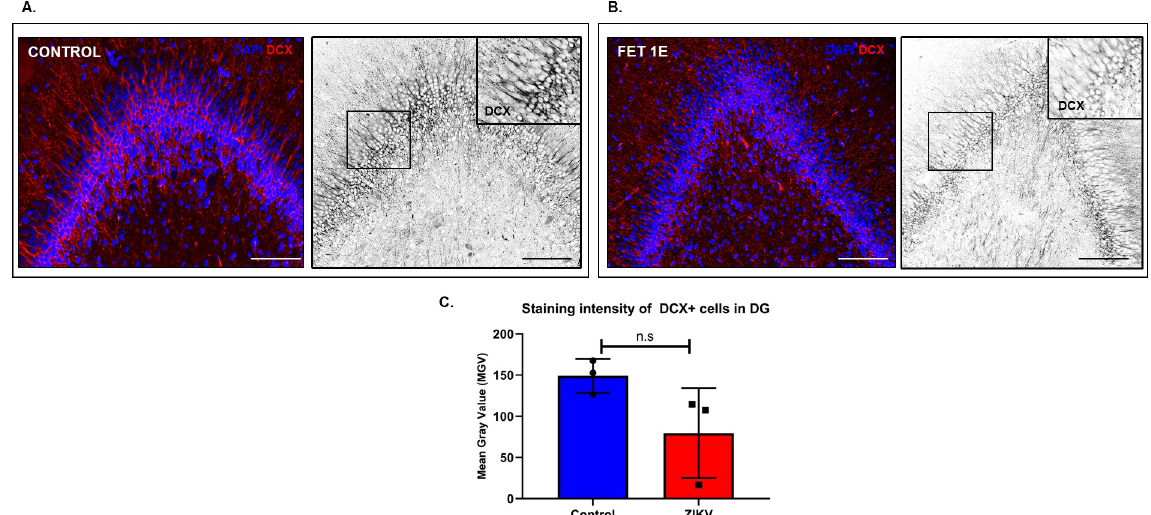
Fig 11. Immunofluorescence (IF) for neuronal migration marker doublecortin (DCX) in the dentate gyrus (DG) ( A ) and hippocampus ( B) in fetal brains from ZIKV inoculated and control dams. Staining intensity of DCX+ neurons localized in the DG was measured as mean grey value (MGV). Control DG showed uniform distribution of DCX+ neurons with strong DCX staining in neuronal processes that appeared uniform and abundant (inset) whereas in fetuses from ZIKV inoculated dams, the DG had DCX+ cells with decreased DCX staining suggesting reduction in dendritic arborization of immature neurons along the DG (inset). ( C ) Difference in MGV of DCX+ neurons between ZIKV and control hippocampus was not statistically significant. (Scale bar = 100 μ m, Error bars depict SD, unpaired t- test, p < 0.05 considered significant).